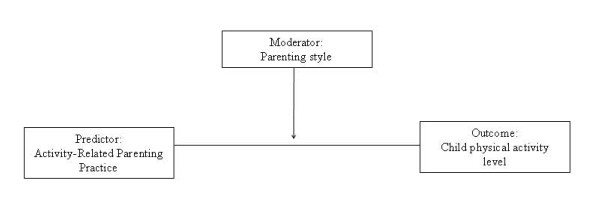
Moderating role of parenting style in the parent-child physical activity relationship. Adapted from Darling and Steinberg's conceptual model [21]of parenting style.